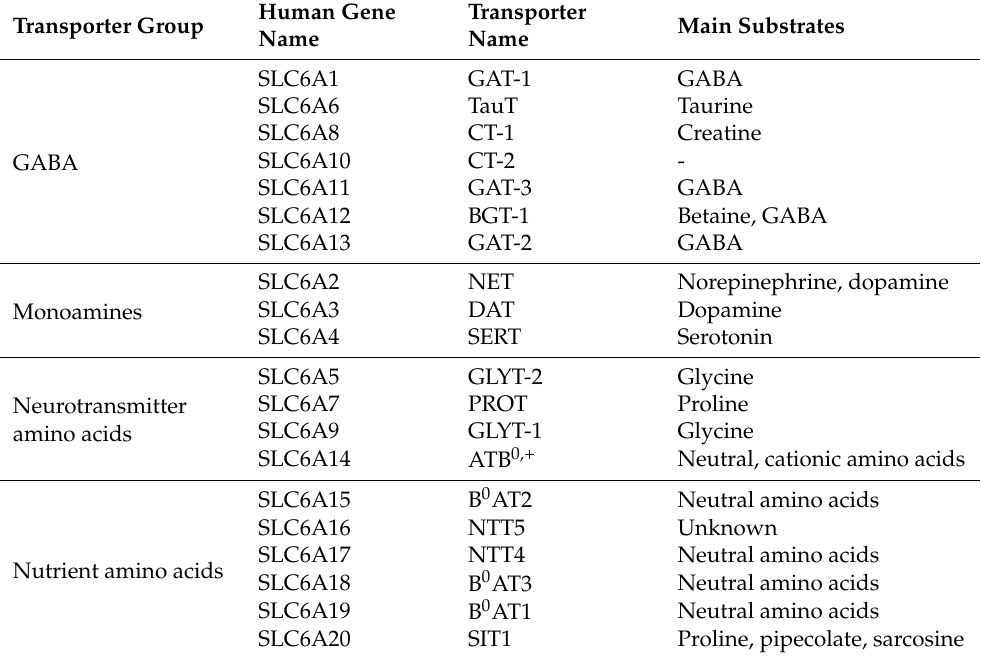
Table 1. SLC6 family transporters are divided into four groups. The table presents transporter